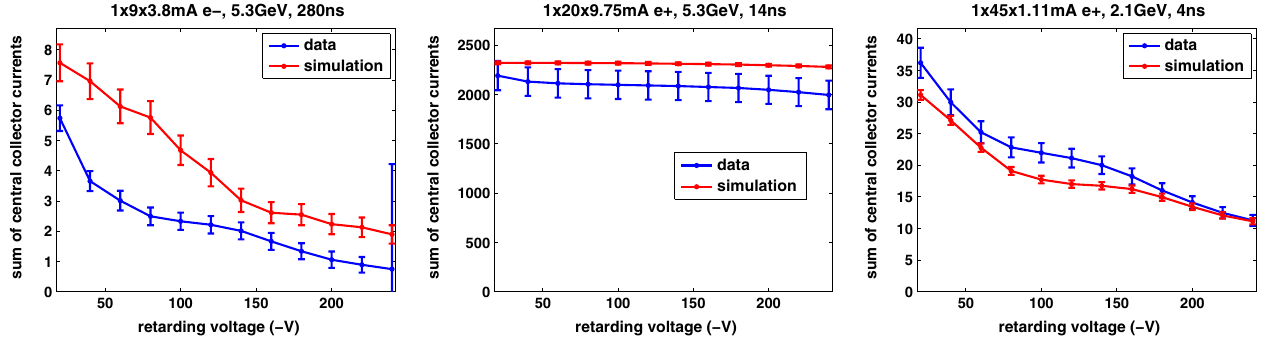
FIG. 11. Comparison of Q15E aC RFA data and simulation, using best fit parameters (Table VII). The RFA is “ thin ” style (Table II). The plots show the signal in the central three collectors vs retarding voltage.